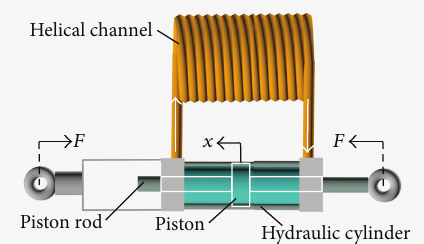
Figure 1: Prototype of fluid